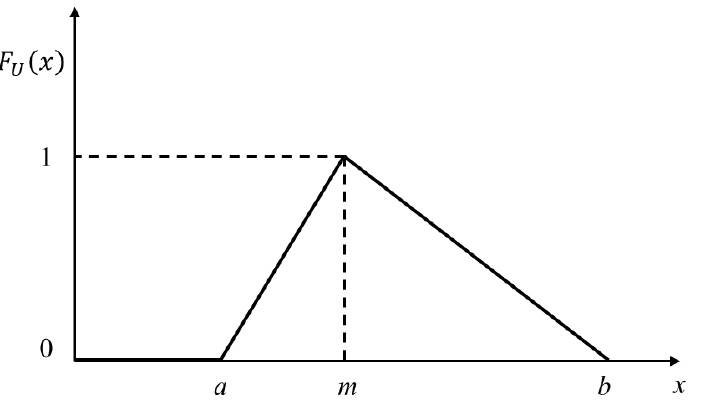
Figure 3. Membership function of a triangular fuzzy number 𝑈̃ .